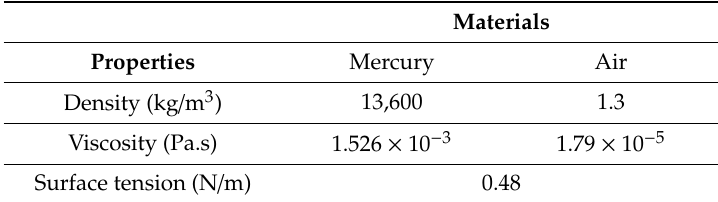
Table 3. The properties of materials.